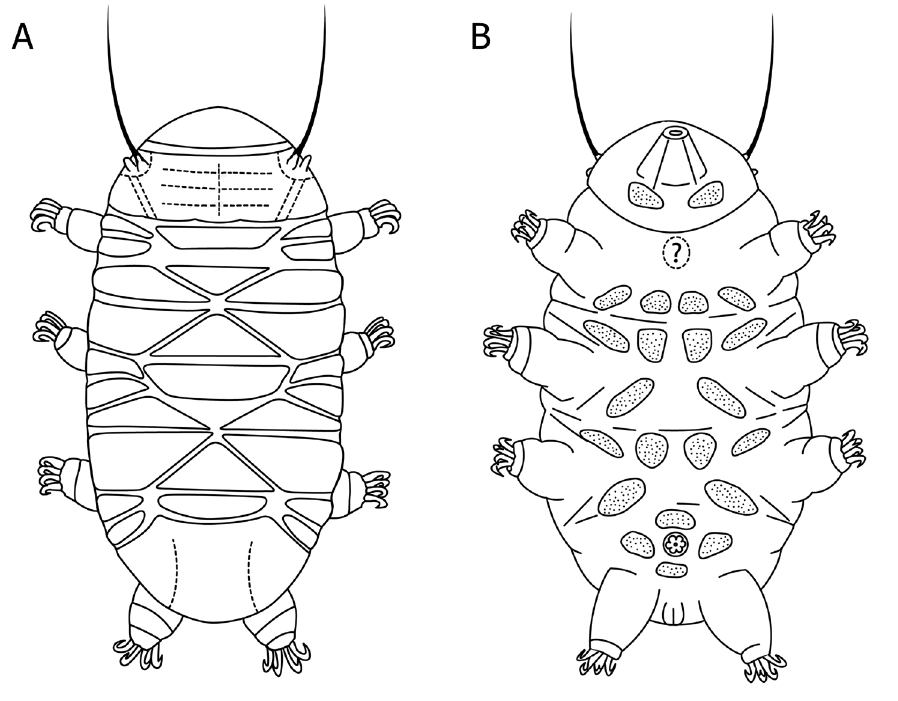
Figure 2. Drawings of the dorsal A and ventral B plates arrangement of Bryodelphax kristenseni sp.